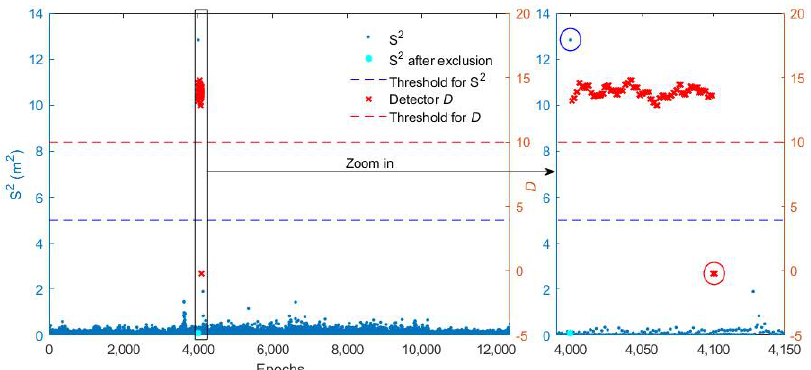
Figure 8. An example of the fault detection results for satellite SV10.